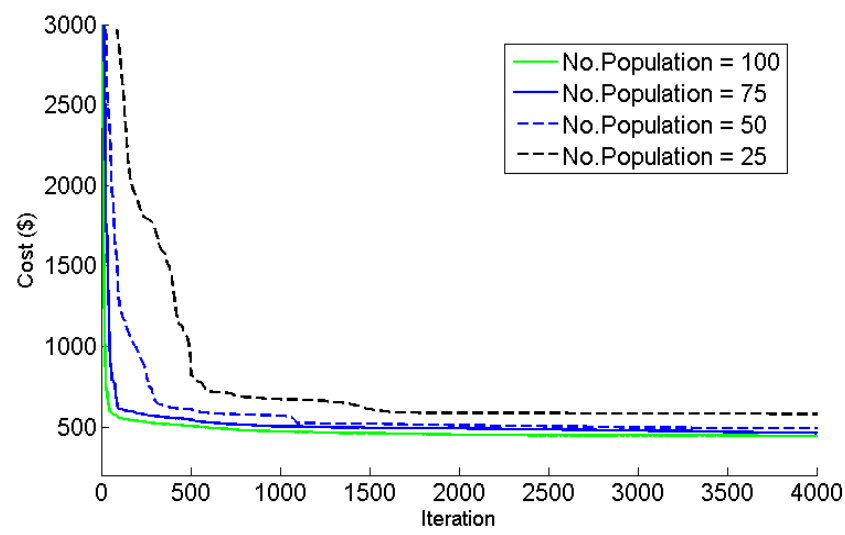
Figure 14. Impact of initial population on convergence of pollution (cost based).